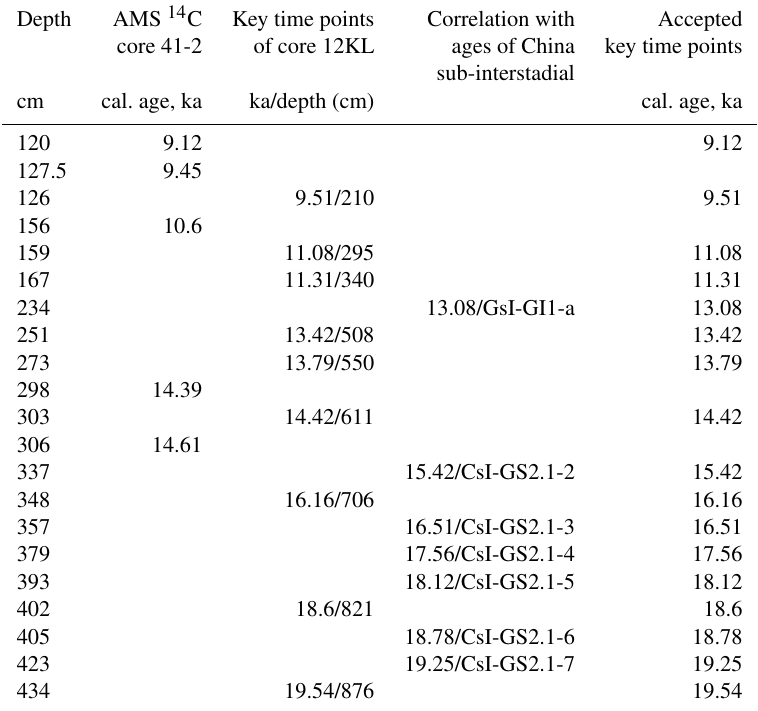
Table 3. The age controlling points of core 41-2 derived from available AMS 14 C data of core 41-2, projection of AMS 14 C ages of core 12KL, and tie points through correlation between increased-productivity events and EASM CsIs (Wang et al., 2008). One AMS 14 C datum of core 12KL at depth of 706cm was accepted according to the Tiedemann/Max age model 2 (Max et al., 2012, 2014). Depth AMS 14 C Key time points Correlation with Accepted core 41-2 of core 12KL ages of China key time points